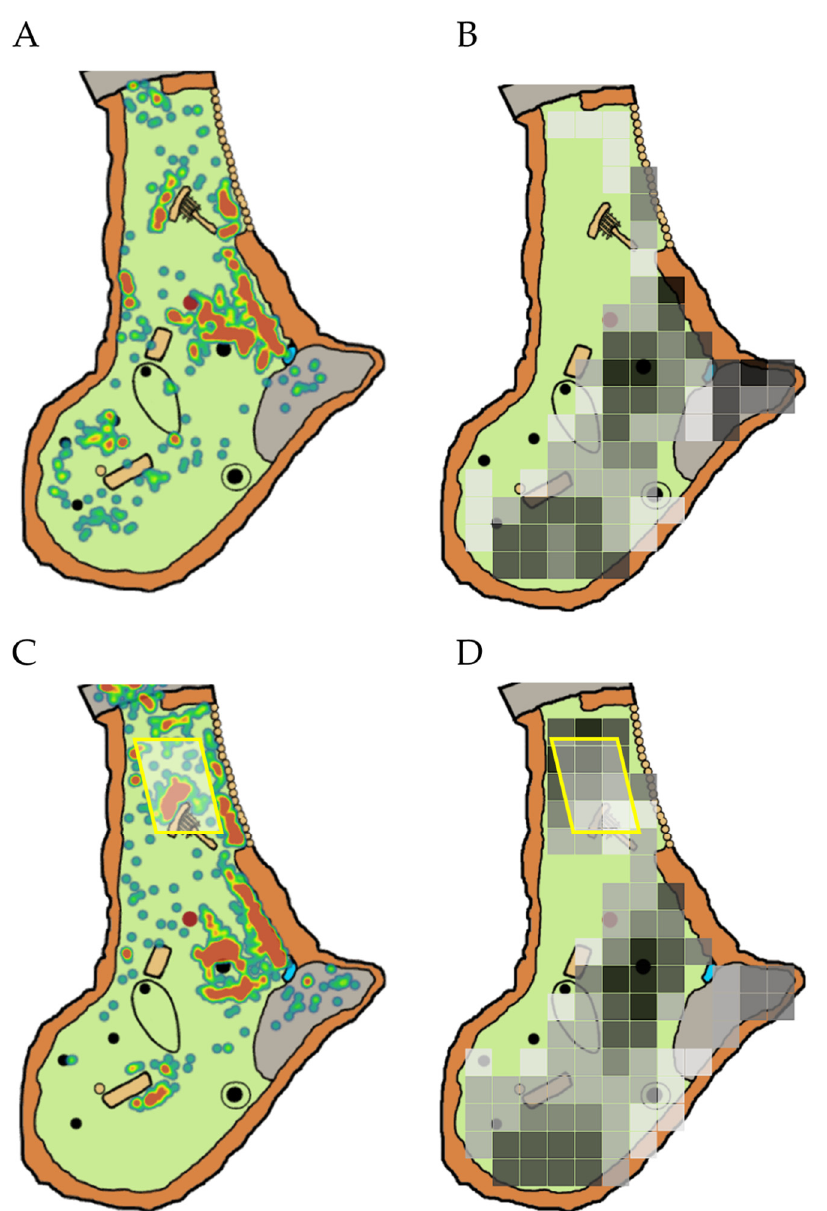
Figure 5. Map visualizations showing space use by three Sichuan takin ( A ) before and ( C ) after installation of a shade sail (indicated by the addition of a yellow rectangle in ( C , D )) and shade availability in the enclosure ( B ) before and ( D ) after shade sail installation. Space use and shade availability are restricted to the months of June and July to allow comparisons across years. Minor changes in shade availability in the front of the enclosure ( B , D ) likely reflect di ff erences in tree growth and maintenance between the two study years.